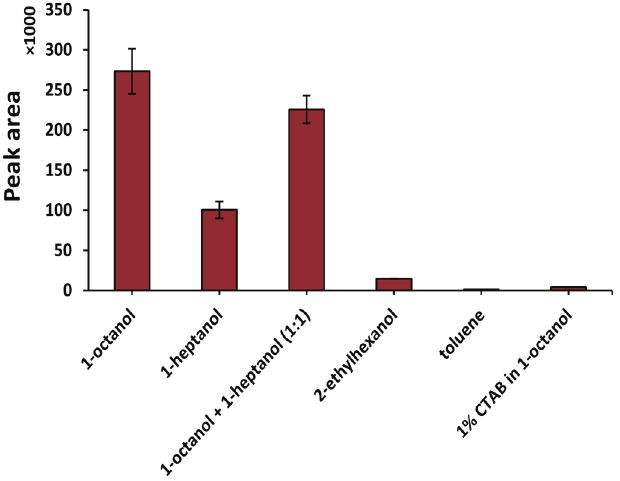
FIGURE 2 - Effect of SLM composition on EME efficiency (concentration of phenobarbital in donor: 1 µg/mL, pH of donor: 8, pH of acceptor: 13, time of extraction: 10 min and voltage: 40